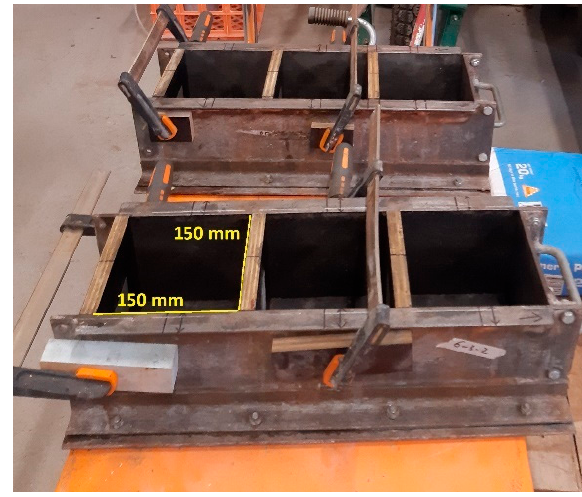
Figure 3 . Moulds for pull-out specimens . Prior to the preparation of the cubic moulds, the basalt FRP bars were marked and fixed in the steel socket using a strong adhesive named HILTI RE500 for better grip in the socket, unlike the conventional cement grout method. The use of an epoxy adhesive of this kind will prevent the failure of FRP bars due to the gripping force of the clamps in the universal testing machine during testing [3]. The basalt FRP bars gripped in the steel socket tubes were left to dry for one week. The embedment length, also known as the bonded length or bond length, was determined with respect to the reinforcing bar’s diameter. The three embedment lengths used in this study were the 5 d b , 10 d b, and 15 d b lengths. The embedment length of 5 d b corresponds to a bonded length equal to 5 times the diameter of the bar. Later, the embedment lengths were marked on the basalt FRP bars, and the unbonded lengths were taped using foams as bond breakers and made ready for casting in the cubic moulds (Figure 4).